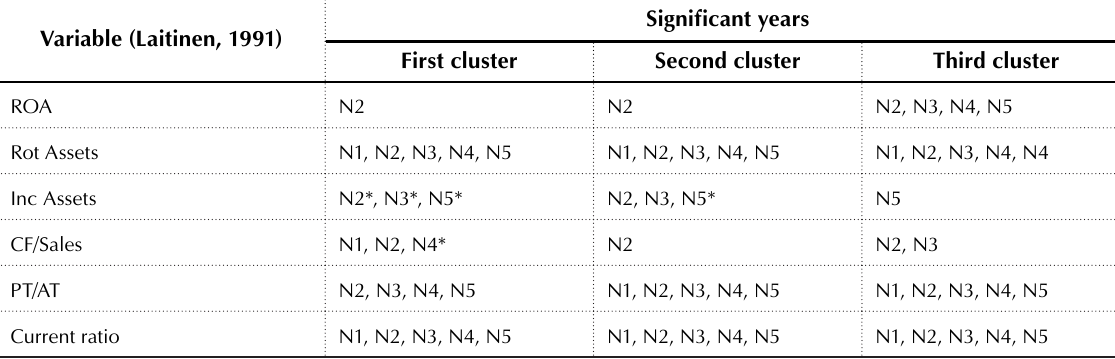
Table 3. Summary contrast K-W by ratios described in Laitinen